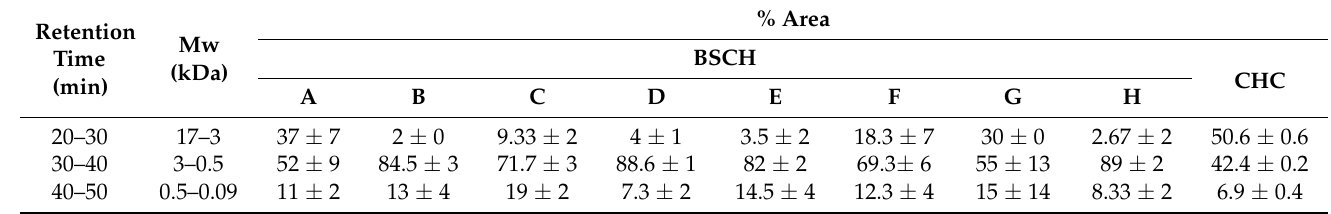
Figure 3. Molecular weight profile of BSCH-C ( a ) and CHC ( b ) obtained using SEC technique. Table 3. The molecular weight distribution of BSCH and CHC using the SEC technique. Values are expressed as percentages of the areas in the chromatograms. Letters A–H indicate different conditions of hydrolysis, which could be consulted in Table